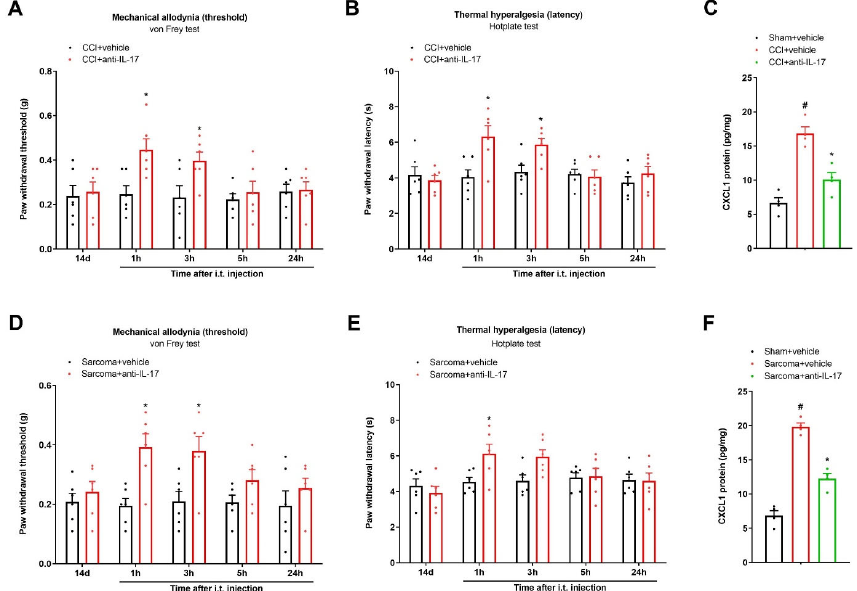
Figure 5. Spinal neutralization of IL ‐ 17 reduced chronic neuropathic pain and bone cancer pain. A neutralizing antibody against IL ‐ 17 (anti ‐ IL ‐ 17) was intrathecally injected (2 μ g) on day 14 after peripheral nerve injuries and sarcoma cell implantations, respectively. Mechanical allodynia ( A ) and thermal hyperalgesia ( B ) after CCI surgeries and anti ‐ IL ‐ 17 injections were documented using von Frey experiments and hotplate experiments, respectively. ( C ) ELISA assay showed that anti ‐ IL ‐ 17 administration reversed the elevated expressions of spinal CXCL1 proteins in CCI animals. # p < 0.05 vs. group sham + vehicle. * p < 0.05 vs. group CCI + vehicle. ( D , E ) Intrathecal injection of anti ‐ IL ‐ 17 impaired the established bone cancer pain in sarcoma ‐ treated mice. ( F ) ELISA assay showed that anti ‐ IL ‐ 17 administration reversed the elevated expressions of spinal CXCL1 proteins in sarcoma animals. # p < 0.05 vs. group sham + vehicle. * p < 0.05 vs. group sarcoma + vehicle. Results from behavioral experiments are presented as the mean ± SEM ( n = 6) and compared using two ‐ way ANOVA followed by Bonferroni multiple comparisons. Results from biochemical experiments are presented as the mean ± SEM ( n = 4) and compared using one ‐ way ANOVA followed by Bonferroni multiple comparisons. i.t. = intrathecal injection.